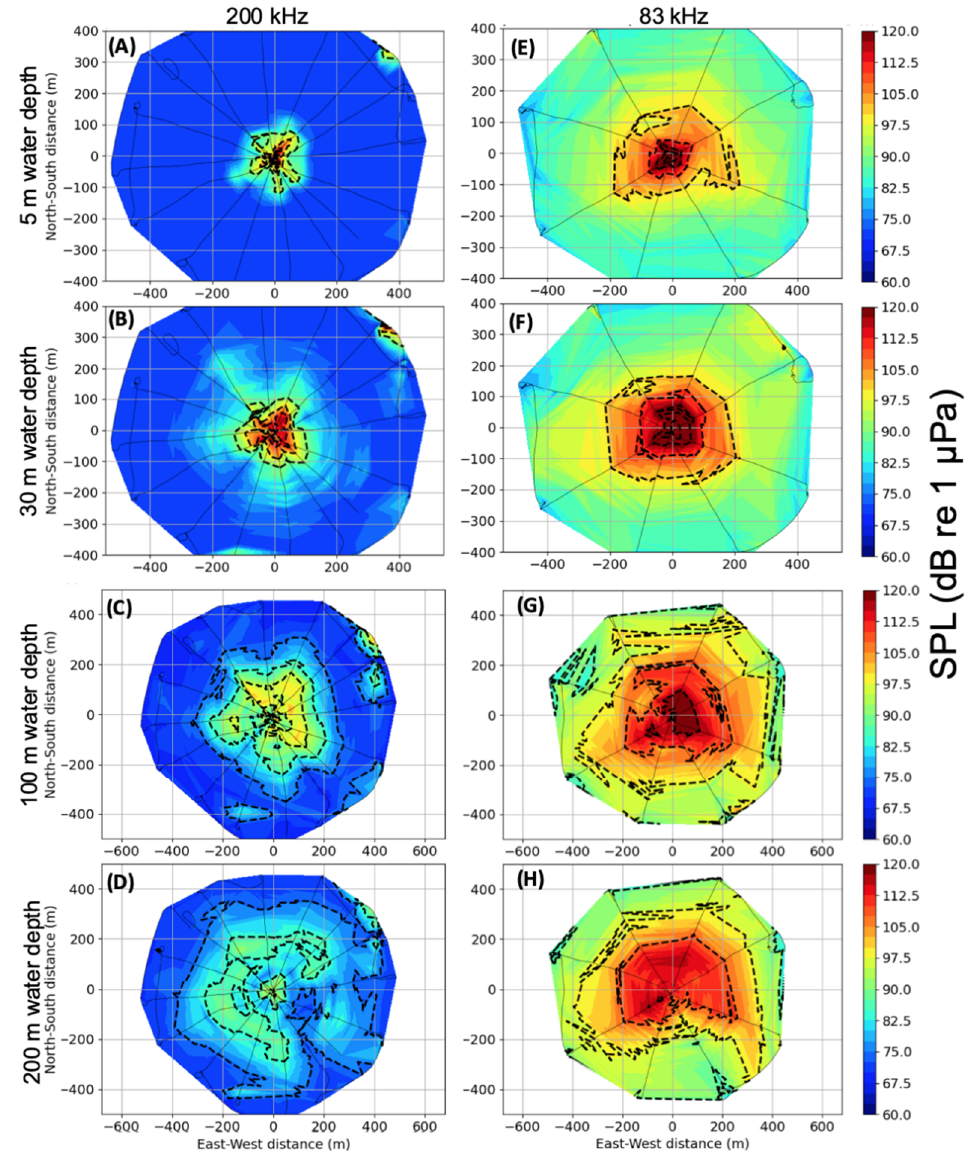
Figure 6. Received sound pressure levels (SPLs) for the 200 kHz signal (198–206 kHz) at the recorder depths of ( A ) 5, ( B ) 30, ( C ) 100, and ( D ) 200 m and for the 83 kHz signal (80–87 kHz) at ( E ) 5, ( F ) 30, ( G ) 100, and ( H ) 200 m from the deep-water transects (black lines). The black dashed lines show the contours of −40 dB below the maximum SPL ((maxSPL) ~80 dB re 1 µPa).